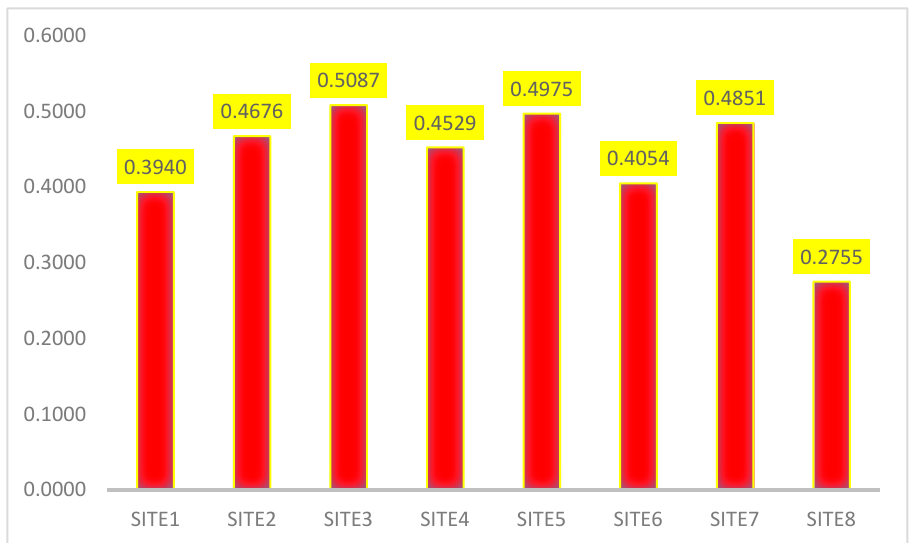
Figure 3. Final ranking score from the technique for order of preference by similarity to ideal solution (TOPSIS) model.